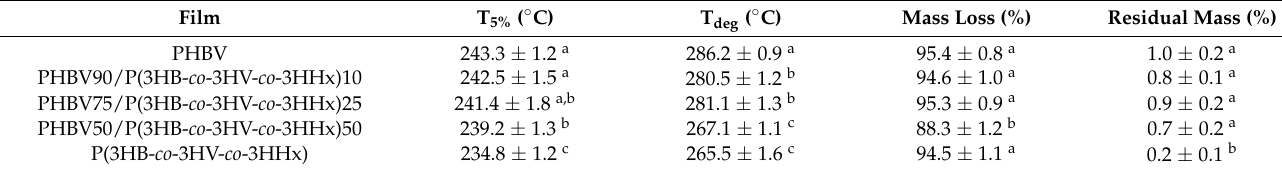
Figure 5. ( a ) Thermogravimetric analysis (TGA) and ( b ) first derivative (DTG) curves of the thermo-compressed films of poly(3-hydroxybutyrate- co -3-hydroxyvalerate) (PHBV), poly(3-hydroxybutyrate- co -3-hydroxyvalerate- co -3- hydroxyhexanoate) [P(3HB- co -3HV- co -3HHx)], and their blends. Table 3. Main thermogravimetric analysis (TGA) parameters of the thermo-compressed films of poly(3-hydroxybutyrate- co -3-hydroxyvalerate) (PHBV), poly(3-hydroxybutyrate- co -3-hydroxyvalerate- co -3-hydroxyhexanoate) [P(3HB- co -3HV- co - 3HHx)], and their blends in terms of: Onset temperature of degradation (T 5% ), degradation temperature (T deg ), mass loss at T deg , and residual mass at 800 ◦